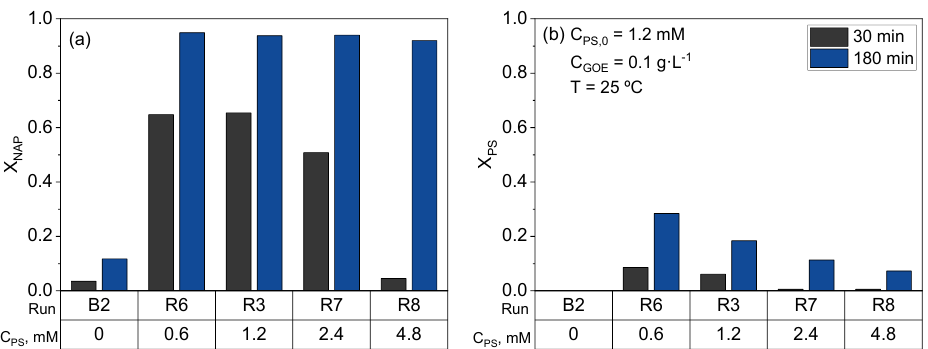
R un Figure 3. Effect of temperature in ( a ) conversion of NAP; ( b ) conversion of PS at 30 min and 180 min. 𝐶 NAP,0 = 0.1 mM,𝐶 PS,0 = 1.2 mM,𝐼 = 0.18 W · cm −2 and 𝐶 GOE = 0.1 g · L −1 . At 40 °C, PS activation by temperature can be performed, generating more sulfate radicals than those obtained at 25 °C [33]. This fact can be experimentally observed since the higher the temperature, the higher the conversion of PS and NAP [34,35]. 2.4. Effect of PS Concentration The oxidant concentration was tested within 0 – 4.8 mM using the same GOE concen- tration and irradiance values. The obtained conversions of NAP and PS are summarised in Figure 4. As shown in Figure 4, negligible NAP oxidation occurred without PS (B2). In runs R6 and R3, using 0.6 mM and 1.2 mM PS concentrations, a similar conversion of NAP was obtained after 30 min of reaction. On the other hand, an initial concentration of PS higher than 2.4 mM resulted in slightly lower values of NAP conversion at 30 min. The observed effect of the higher PS concentration and the lower NAP conversion can be ex- plained by the reactions in Equations (7) and (8). This phenomenon was in agreement with Zeng [13] et al. and Kusic et al. [36]. They concluded that the production of 𝑆𝑂 4−  increases with the increase in PS. The radical sulfate in high concentrations reacts with the PS (Equa- tion (7)), resulting in the unproductive reaction of the oxidant. In addition, SO 4 − • in high concentrations can be self-consumed in a self-inhibitory reaction (Equation (8)); therefore,